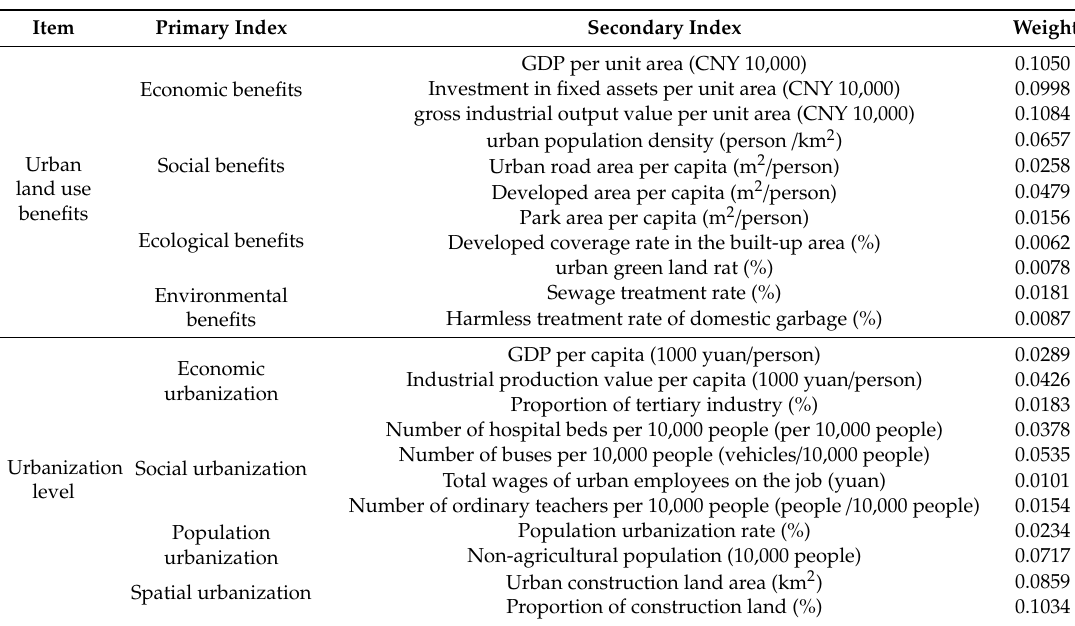
Table 2. Evaluation index system of urban land use benefits and urbanization